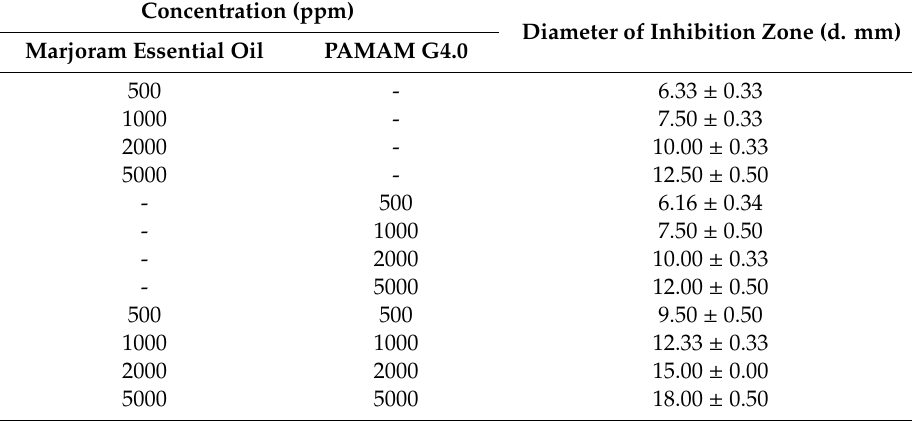
Table 1. Average diameters of inhibition zone against Phytophthora infestants of Marjoram essential